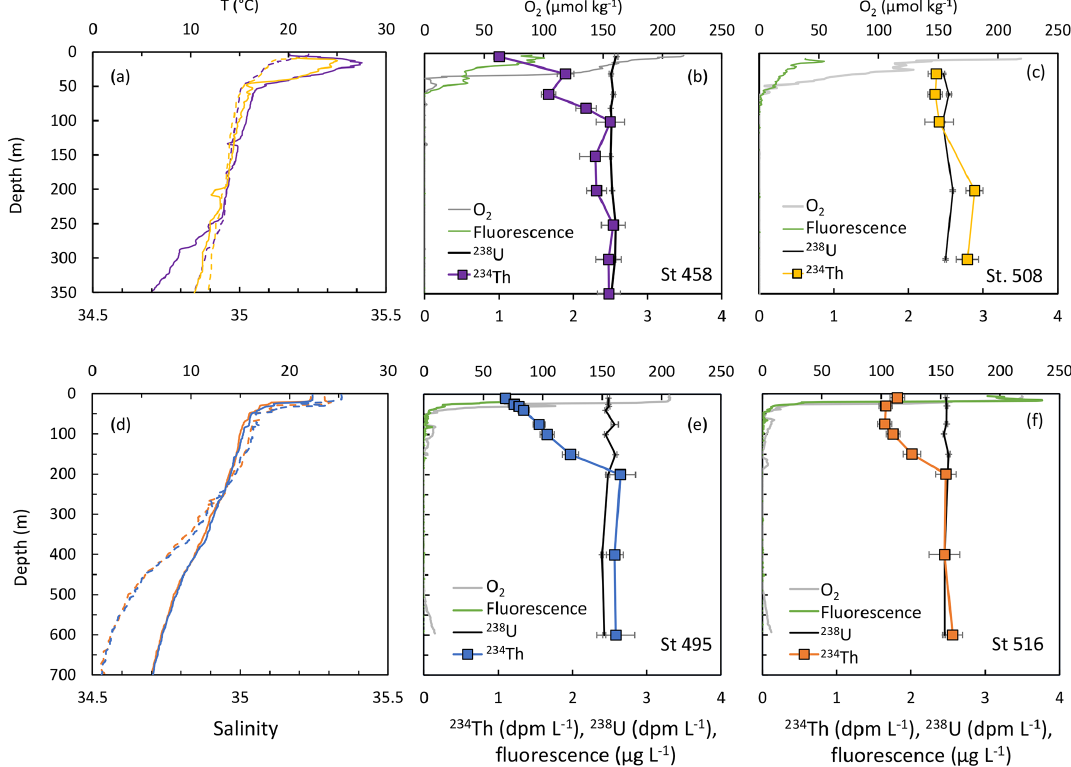
Figure 5. Profiles of temperature (solid lines) and salinity (dashed lines) for repeated stations (a) 458 (purple) and 508 (yellow) and (d) 495 (blue) and 516 (orange). Panels (b) and (c) are respectively profiles for stations 458 and 508 of 238 U (black), 234 Th (color squares), and concentrations of oxygen (grey) and fluorescence (green). Panels (e) and (f) are respectively profiles for stations 495 and 516 of 238 U (black), 234 Th (color squares), and concentrations of oxygen (grey) and fluorescence